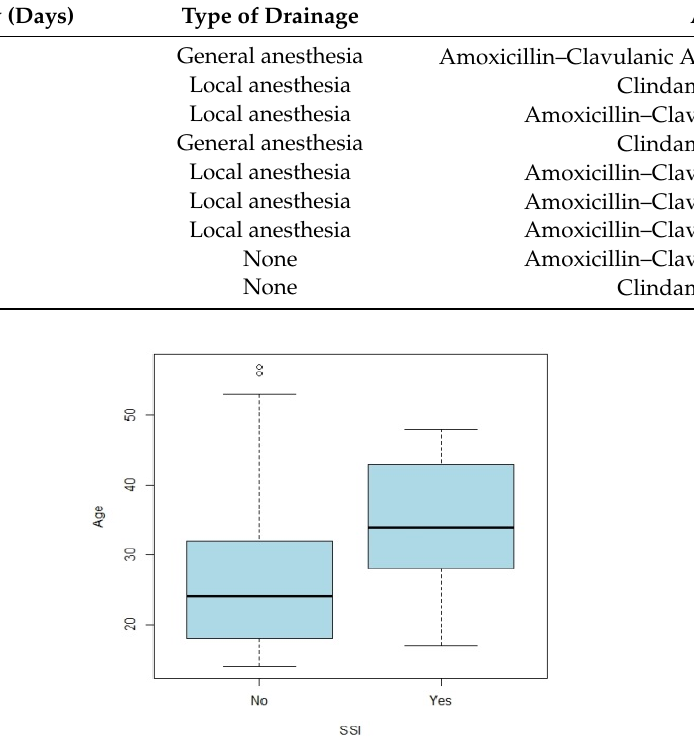
Figure 2. Association between age at surgery and SSI.